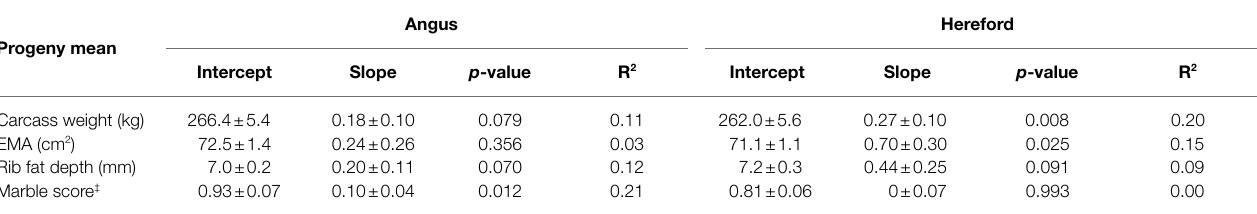
TABLE 5 | Estimates of regression coefficients (intercept and slope) of least-squares means of beef-cross-dairy progeny groups for carcass traits (carcass weight, eye muscle area (EMA), rib fat depth, and marble score) on corresponding sire EBV, for 29 Angus and 34 Hereford sires. Angus Hereford Progeny mean Intercept Slope p -value R 2 Intercept Slope Carcass weight (kg)